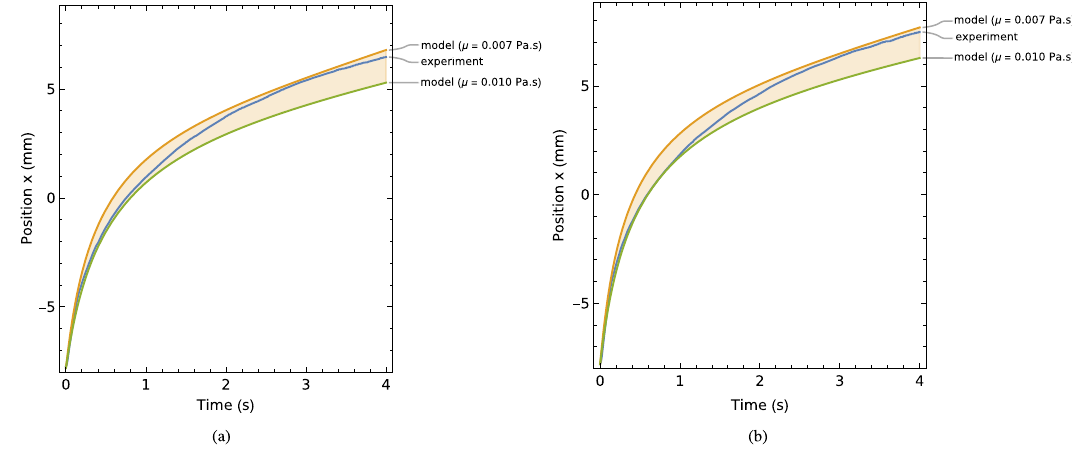
Figure 14. Displacement response of the tested actuator following coil activation with current of ( a ) 4 A and ( b ) 5 A. Results from model-based simulations are also shown for each